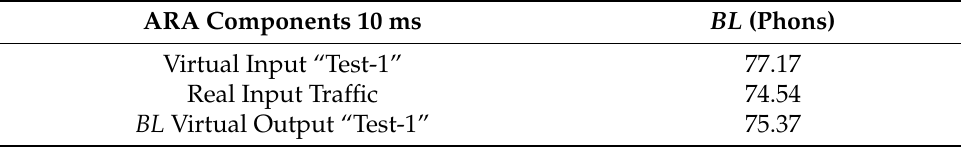
Table 3. BL Inputs and Output of